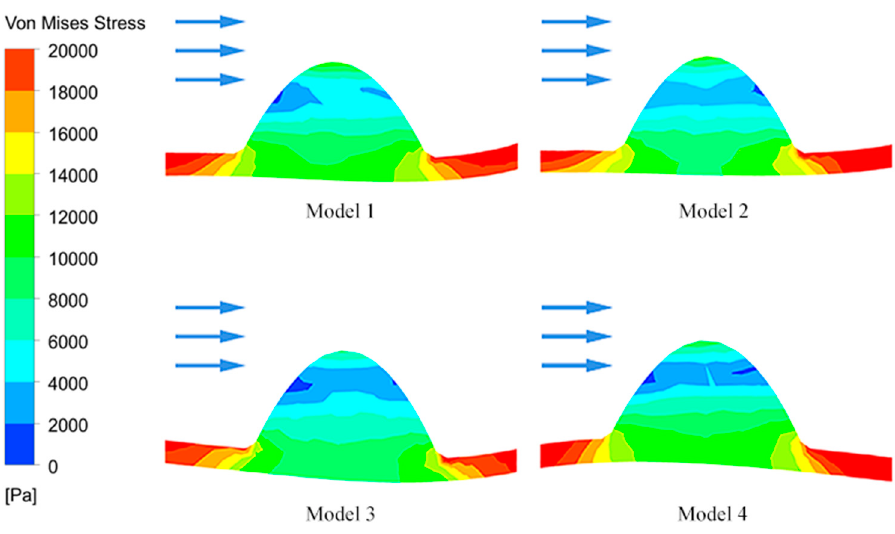
Figure 5. VMS contours at the plaque at peak systole.